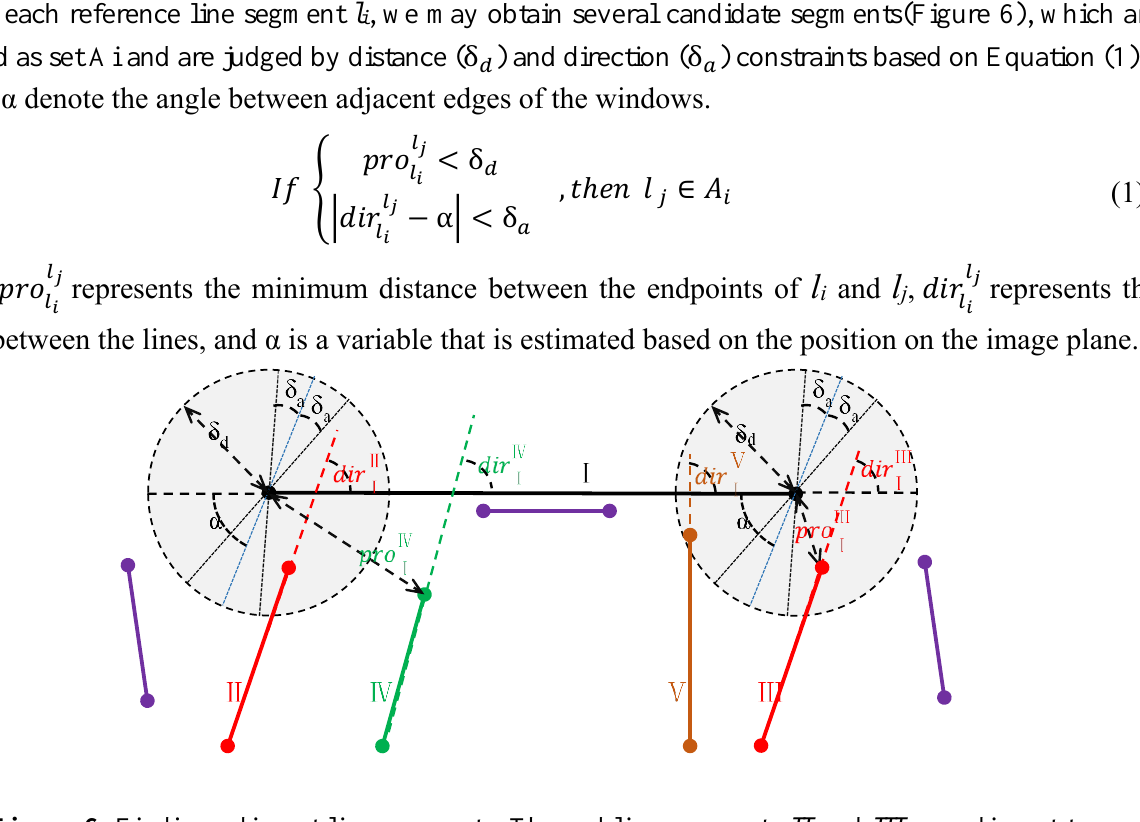
Figure 6. Finding adjacent line segments. The red line segments II and III are adjacent to line segment I because the end points are within the adjacent regions and the angles are within the ranges. Line segments IV (green) and V (orange) are either too distant or at too high an angle to include, and the purple segments are excluded because they do not meet both conditions. Thus, set A I = { II , III } is